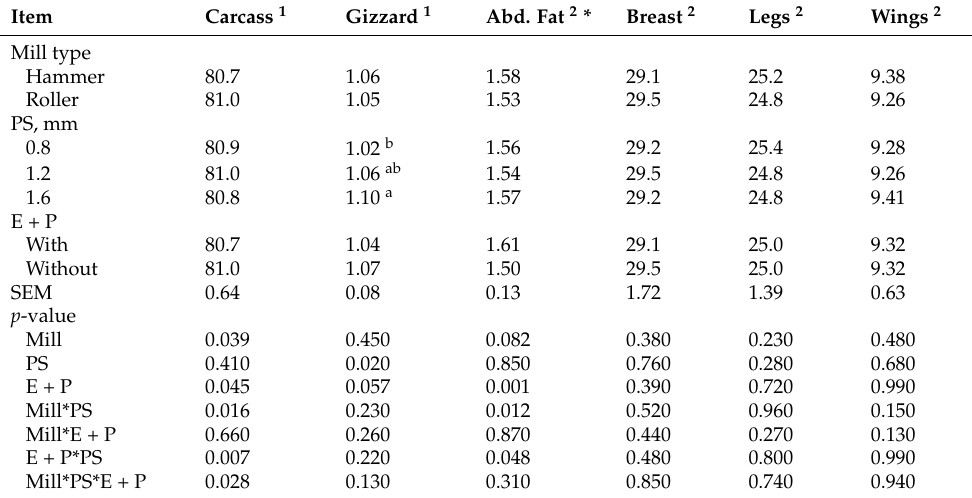
Table 7. Slaughter performance and gizzard weight of broilers fed diets ground using two types of mill at three particle sizes (PS), submitted to conditioning with or without expander (E + P) prior